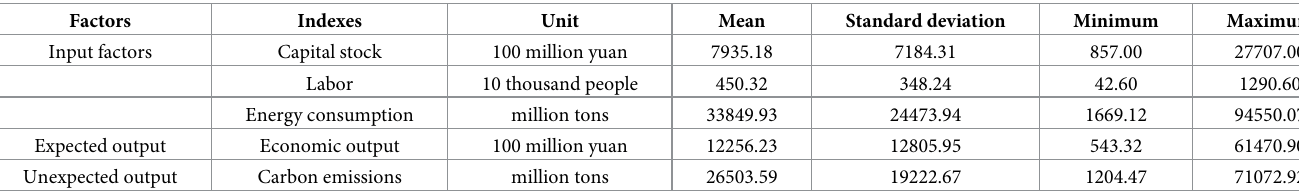
Table 2. The statistical description of the input-output indicators from